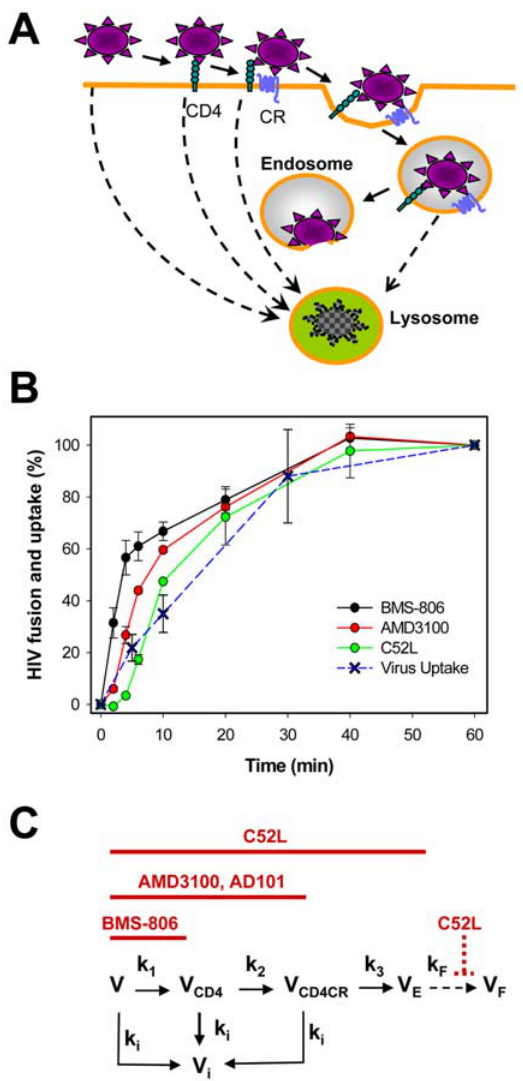
Figure 1. Dissection of early steps of HIV-1 fusion with target cells. (A) A schematic drawing showing HIV-1 entry via receptor- mediated endocytosis followed by fusion with endosomes. Pathways leading to virus degradation in lysosomes are shown by dashed lines. CR denotes coreceptor. (B) Kinetics of surface-accessible steps of HIV-1 fusion with TZM-bl cells. HXB2 pseudoviruses were pre-bound to cells in the cold and triggered to fuse by raising the temperature at time=0. Inhibitors of CD4 binding (BMS-806), coreceptor binding (AMD3100) and the 6-helix bundle formation (C52L) were added at varied times of incubation to block the respective steps of fusion. The resulting extent of fusion as a function of incubation time was measured by a BlaM assay. The total virus uptake was measured by the fraction of pronase- resistant viral p24 (see Materials and Methods). Error bars are SEM. (C) A kinetic model of HIV fusion. The virus (V) progresses through CD4 and coreceptor (CR) binding steps and undergoes endocytosis (V E ) that leads to fusion (V F ). Stages of fusion sensitive to inhibitors, BMS-806, AMD3100 (CXCR4 binding), AD101 (CCR5 binding), and C52L are indicated by horizontal red lines. In this scheme, protection from C- peptides occurs via receptor-mediated endocytosis, but not through 6- helix bundle formation and fusion with the plasma membrane. Native viruses and those that engage CD4 and CD4/coreceptor are assumed to be inactivated with the rate constant k i , primarily due to a non- productive endocytosis.